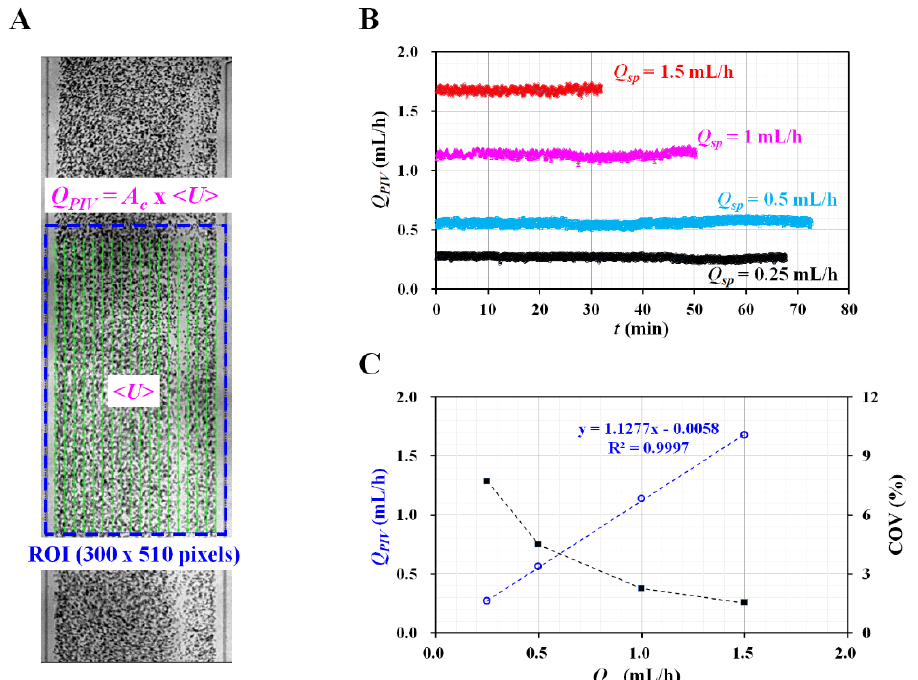
Figure A1. Validation of flow rate of reference fluid controlled by syringe pump. ( A ) Quantification of flow rate of reference fluid with microparticle image velocimetry. ( B ) Temporal variations of Q PIV with respect to flow rate of syringe pump ( Q sp ) = 0.25, 0.5, 1, and 1.5 mL/h. ( C ) Variations of Q PIV and coefficient of variance (COV) with respect to Q sp .